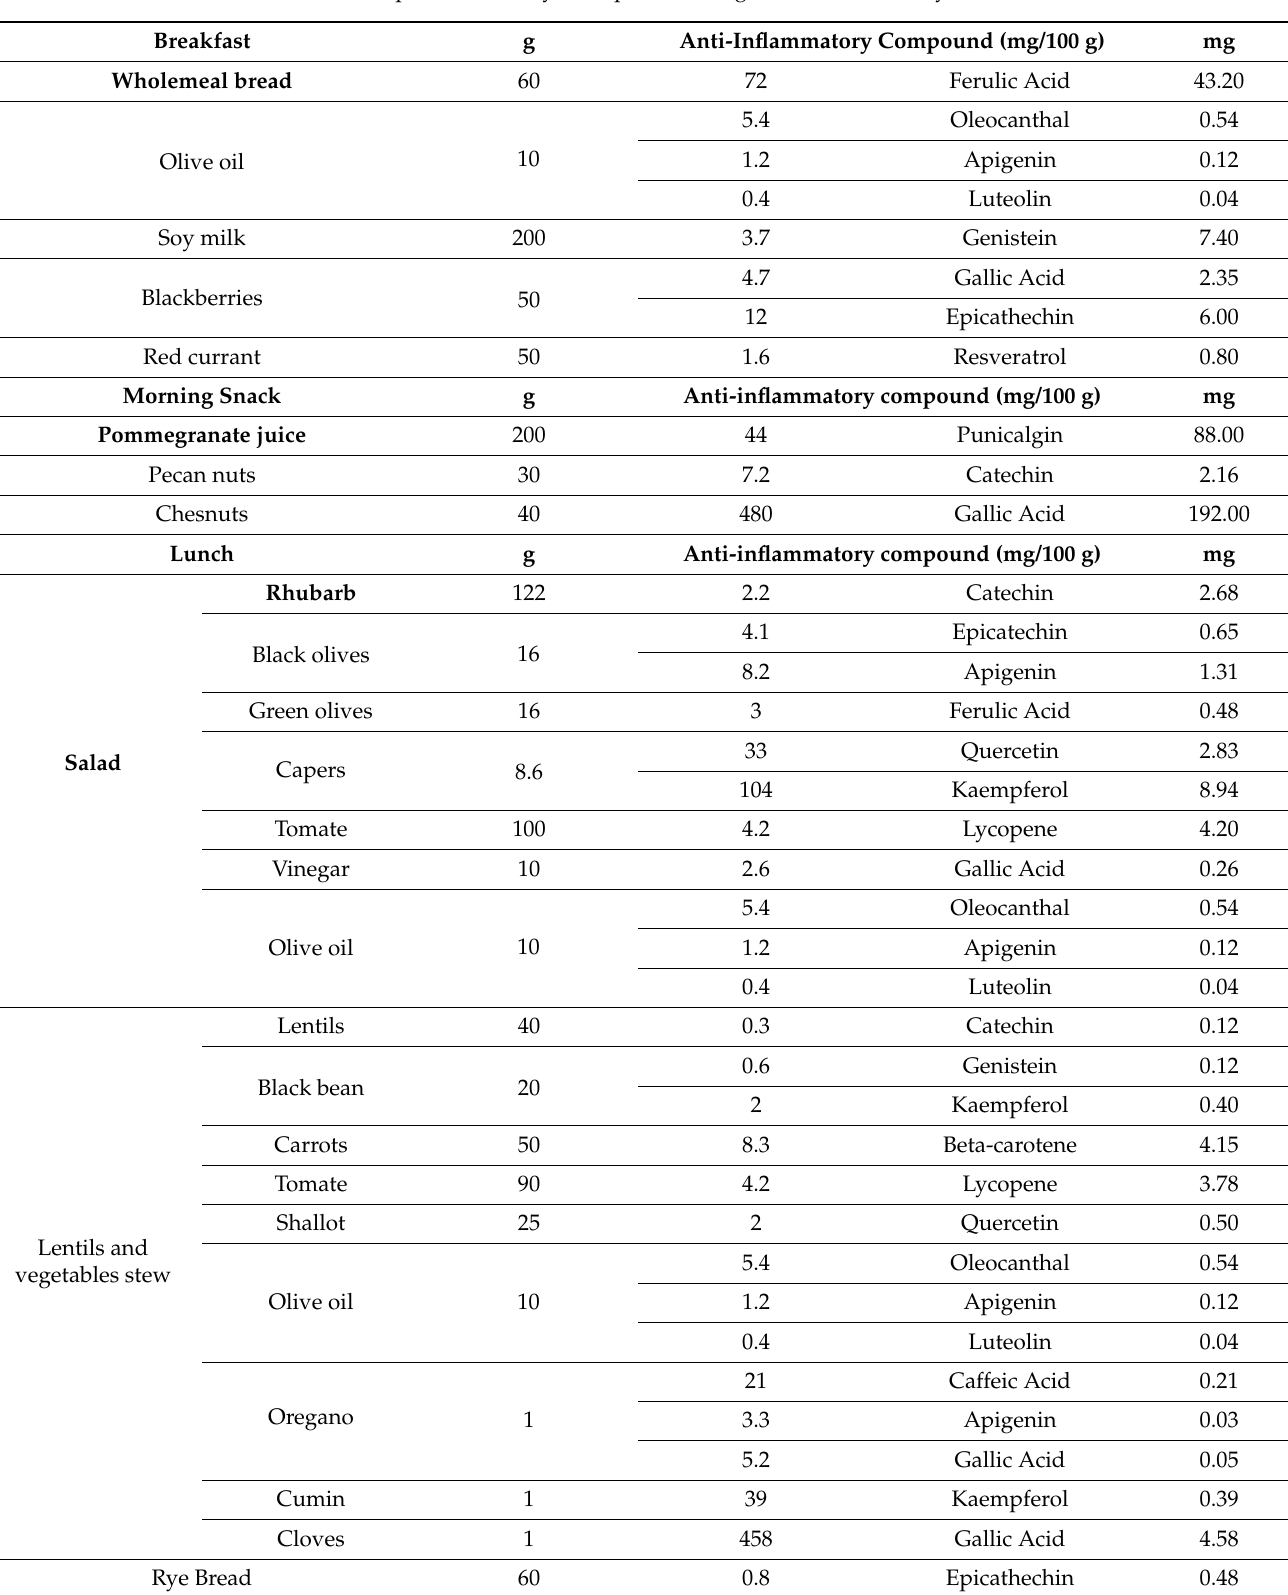
Table 3. Example of a one-day meal plan with high anti-inflammatory